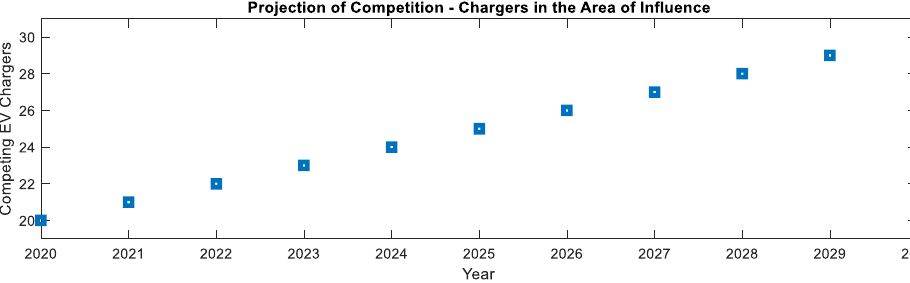
Figure 16. Chargers in the region of influence showing linear growth of competition.